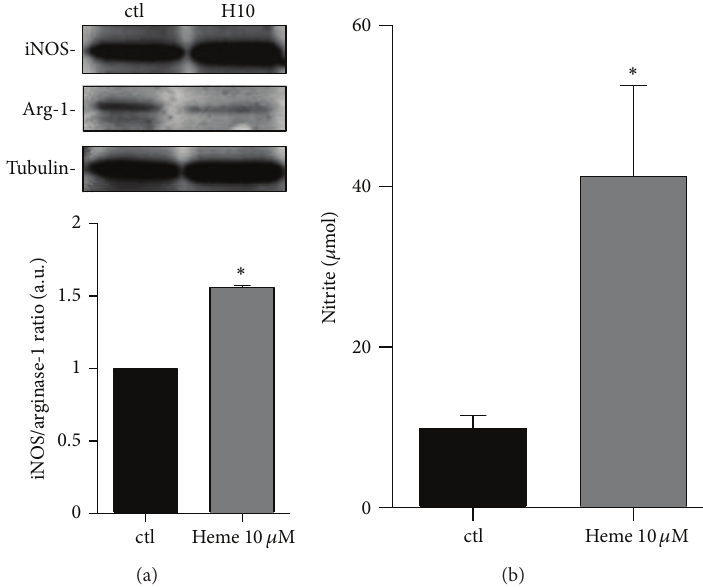
Figure 4: Heme induces NO production by AM. (a) Rat AMs (1 × 10 6 /mL) were pretreated with heme (10 𝜇 M) for 8 hours. Incubations were terminated by the addition of lysis buffer and lysates were subjected to immunoblotting with anti-iNOS, anti-arginase-1, and anti-tubulin antibodies. Results are demonstrated as the iNOS/Arg-1 ratio. Tubulin was used as a loading control. (b) Rat AMs (2 × 10 5 /mL) cultured in 96-well plates were pretreated with heme (10 𝜇 M) for 24 hours. NO production was assessed by the Griess reaction and read on an Envision plate reader, as previously described [29]. The data shown are representative of three independent experiments. The mean ± S.D. is presented. ∗ 𝑃 < 0.05 when compared with controls.